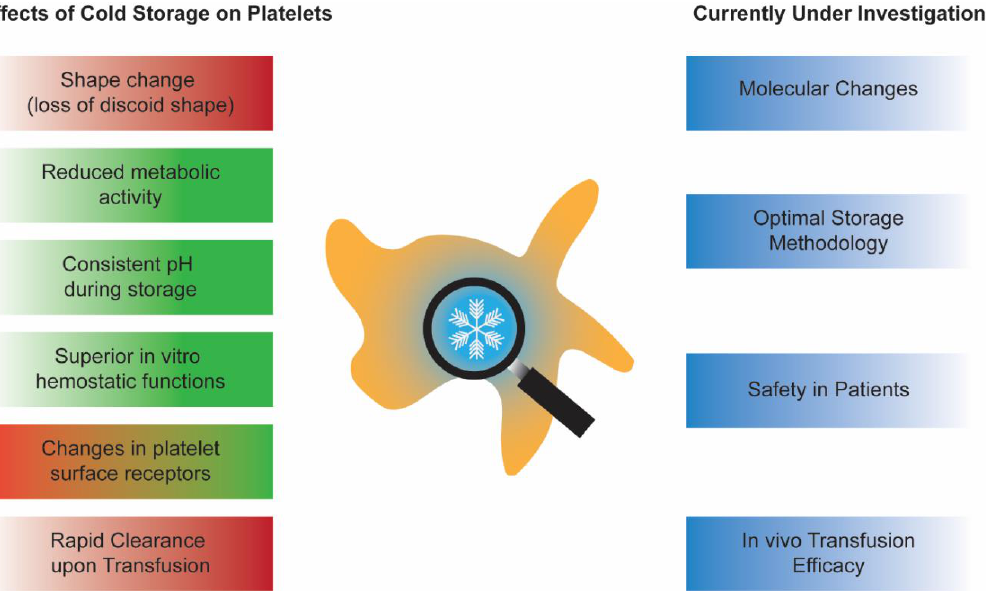
Figure 1. Summary of known effects of cold storage on platelets and aspects of cold-stored platelets currently under investigation. Deleterious effects of cold storage are shaded in red, whereas beneficial effects are shaded in green. The box shaded with red and green colors represents conflicting effects of cold storage on platelet surface